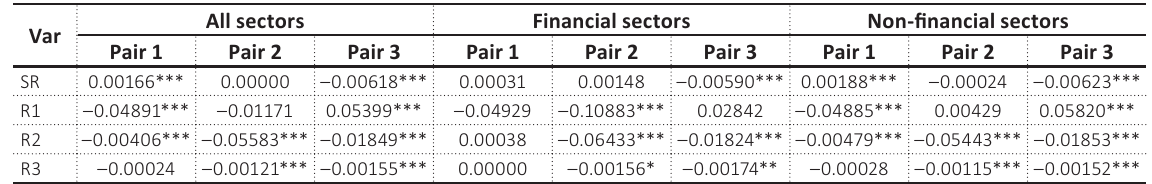
Table 4. Independent sample t -test